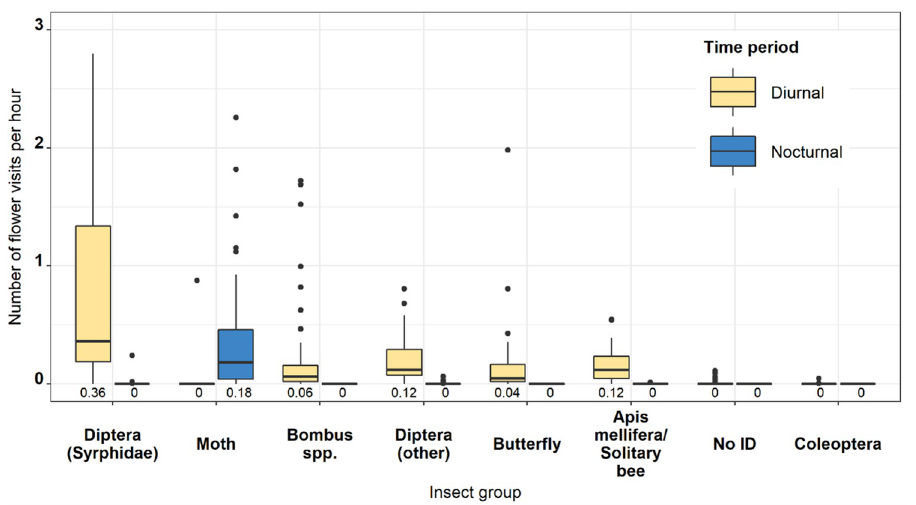
Fig 1. Boxplot showing the number of flower visits (hour -1 ) for each insect taxonomic group during the nocturnal and diurnal time periods. Black dots represent outlying data points and median values are presented beneath each